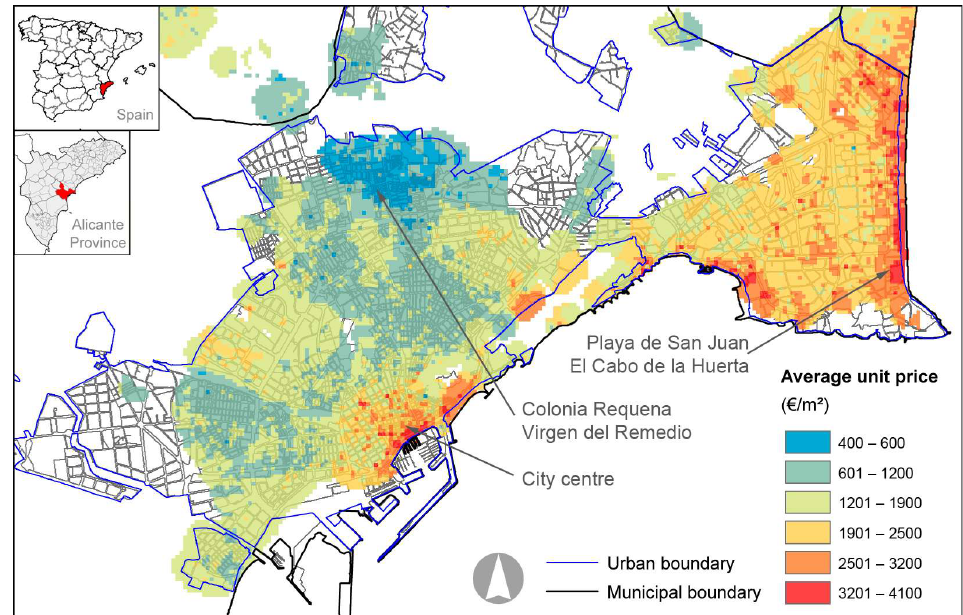
Figure 2. Spatial distribution of sales prices of multifamily housing in the city of Alicante (2021). Interpolation method inverse distance weighting (IDW), pixel resolution 10 × 10 m, 33,200 observations belonging to the municipalities of Alicante, San Vicente del Raspeig, and Campello.